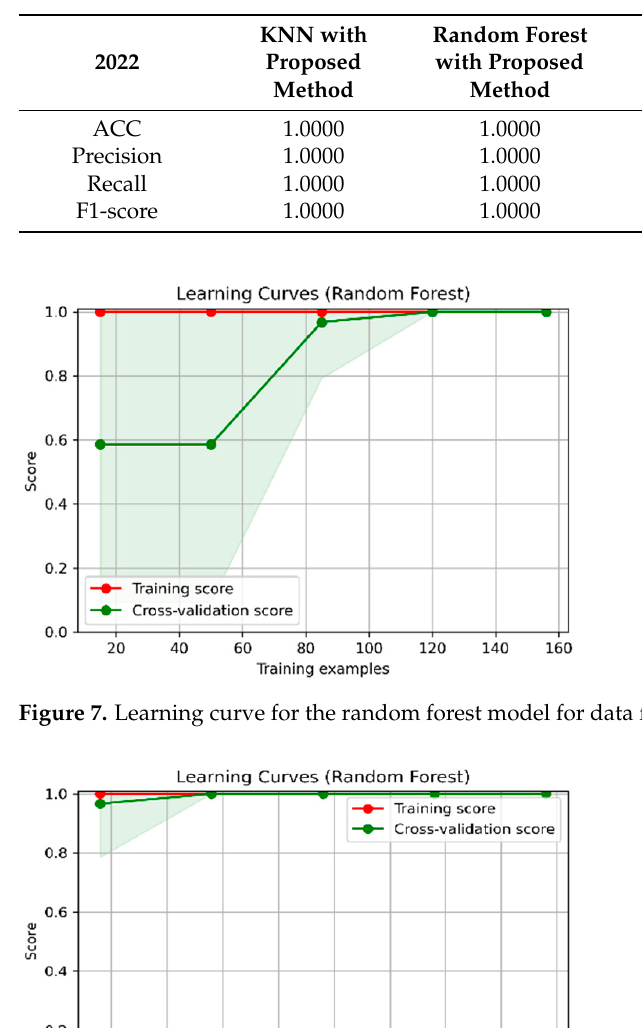
Table 4. Results from complex forecasting models for sequential feature extraction from data for 2022.